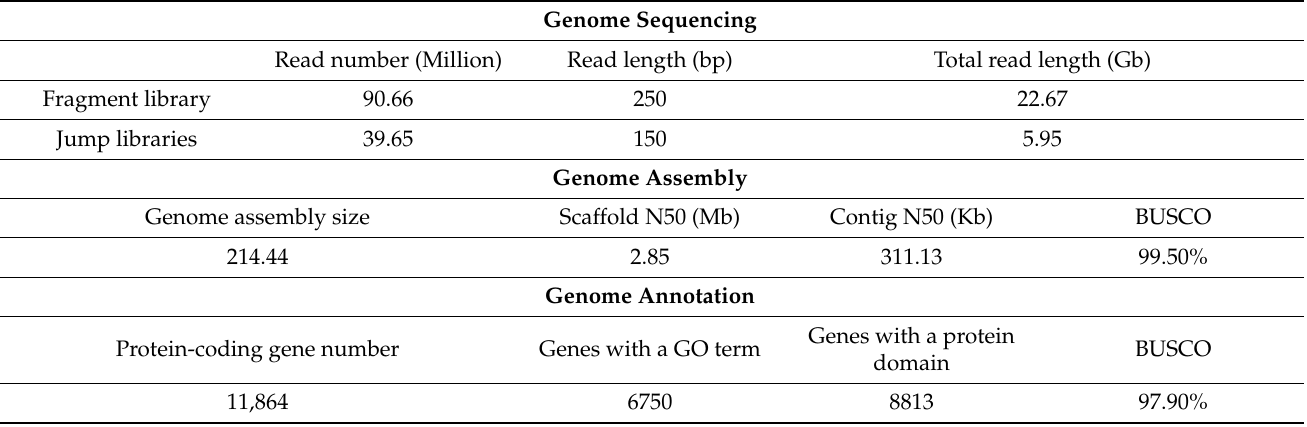
Table 1. The results of genome sequencing, assembly and annotation for A. cerana in